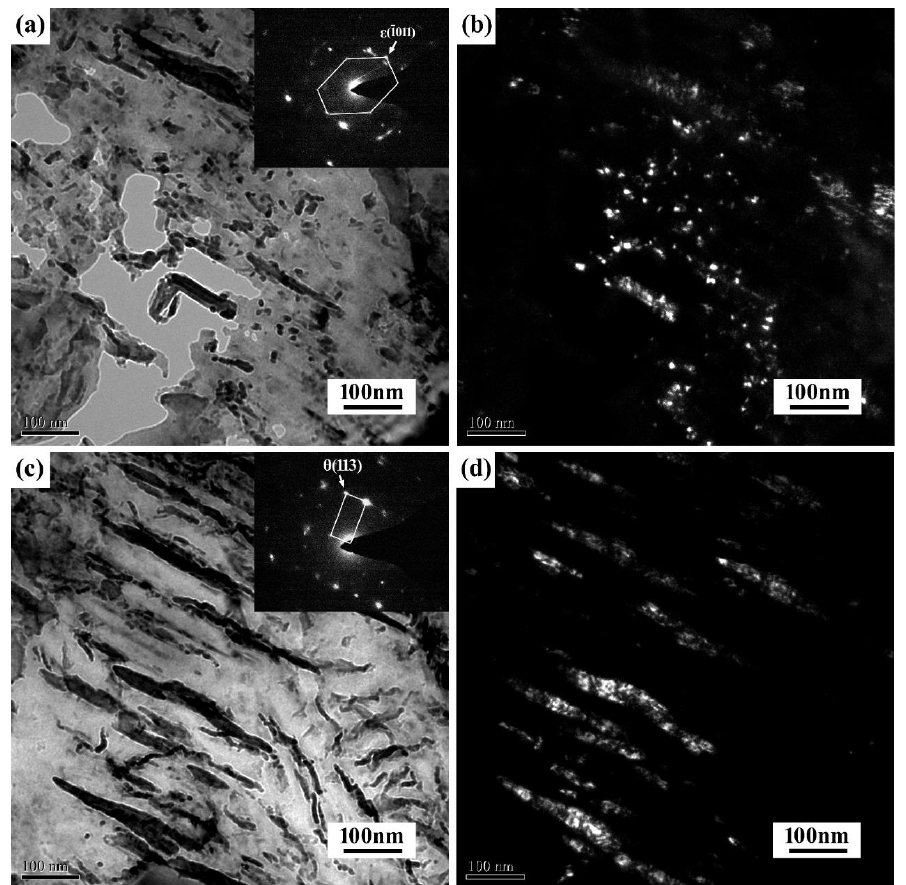
Figure 7. The presence of ε-carbides and θ-carbides for the specimens ( a ) without stress and ( c ) with 40 MPa, respectively. Where ( b , d ) are the corresponding dark field of ( a , c ),